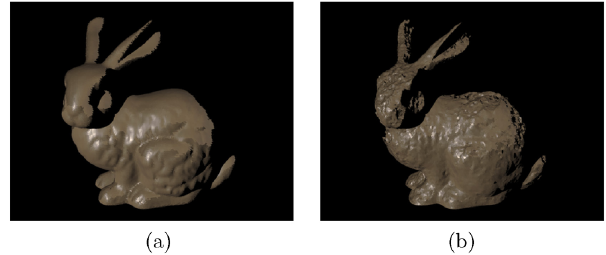
Fig. 7 (a) Example distant light image. (b) Example rendered image using the reconstructed BRDF and reconstructed geometry. Comparing the intensity distribution in (a) and (b) allows us to determine the best reconstructed BRDF.